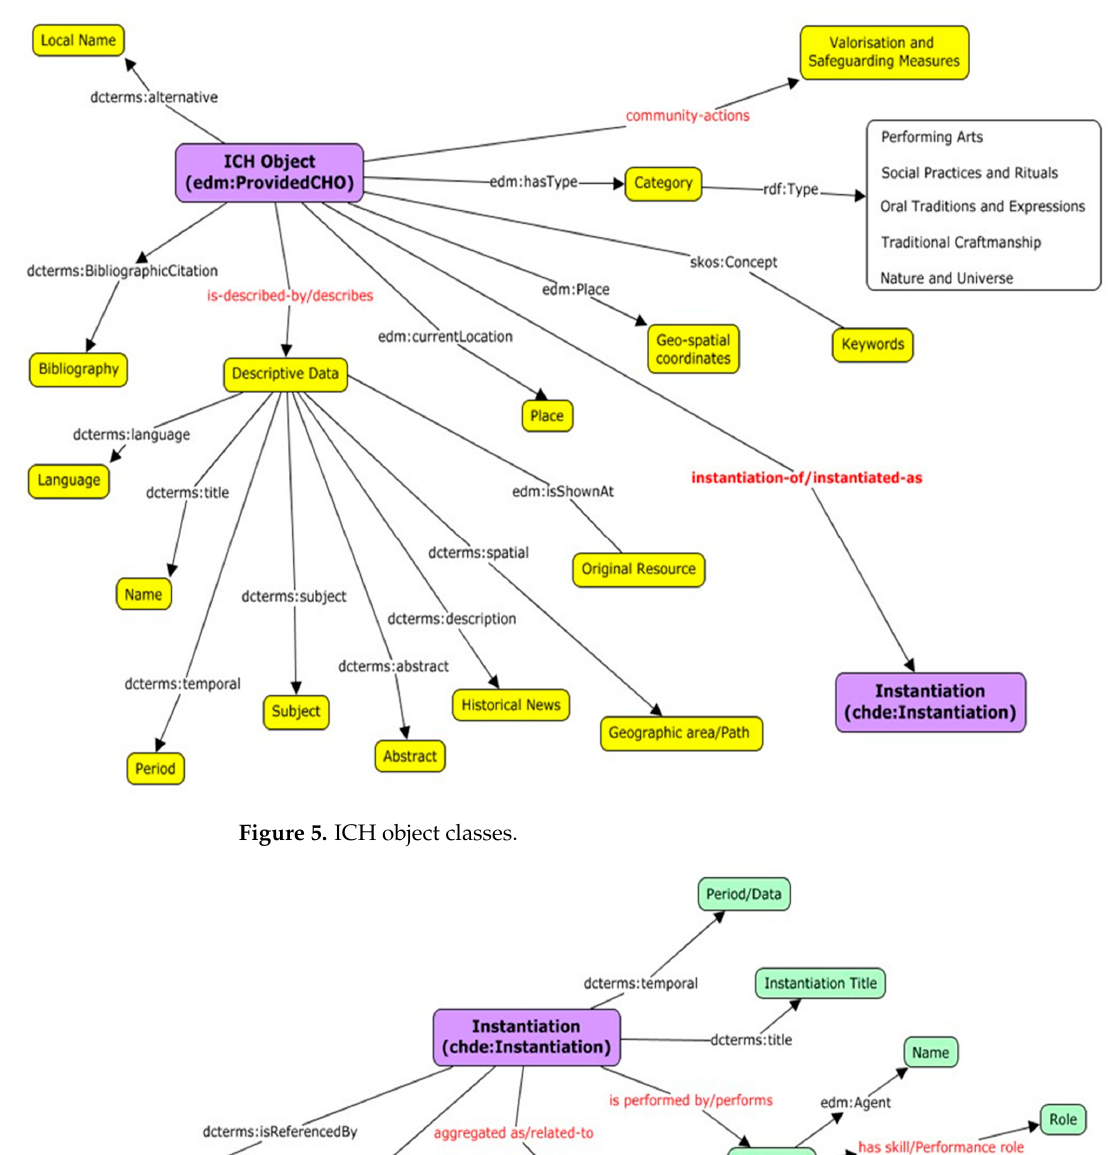
Figure 5. ICH object classes.